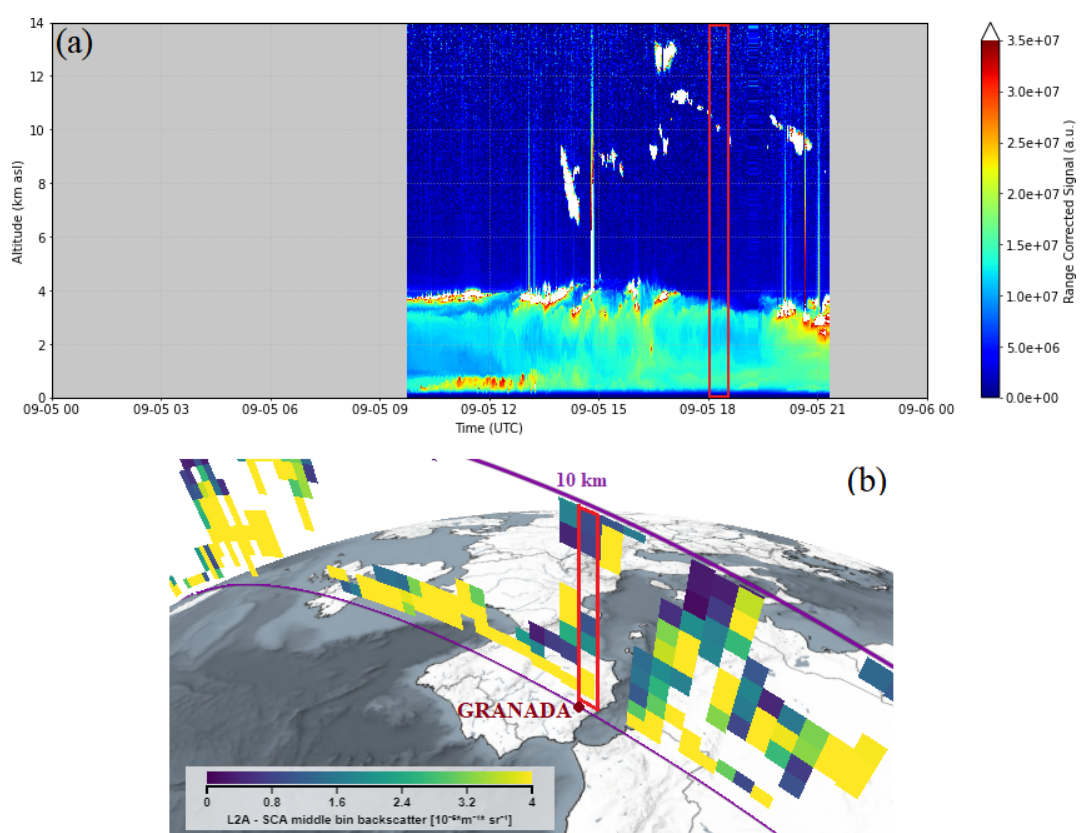
Figure 3. (a) Lidar range-corrected signal measured at 1064nm in Granada on 5 September 2019. (b) Aeolus SCAmb backscatter retrievals along the considered orbit (6007) with the profile closest to the station marked in red (source: VirES for Aeolus, https://aeolus.services/, last access: 7 January 2022). Quality flags are